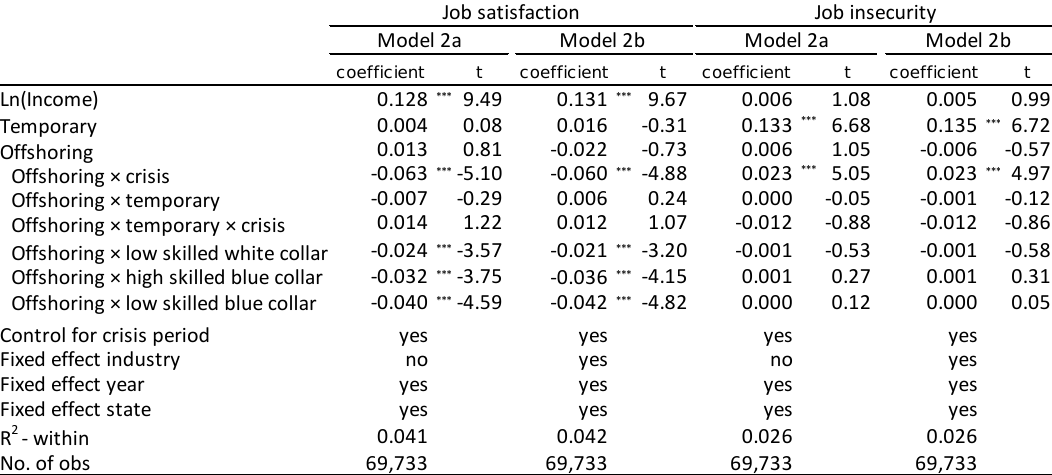
Table 7. Job satisfaction, job insecurity, offshoring and temporary